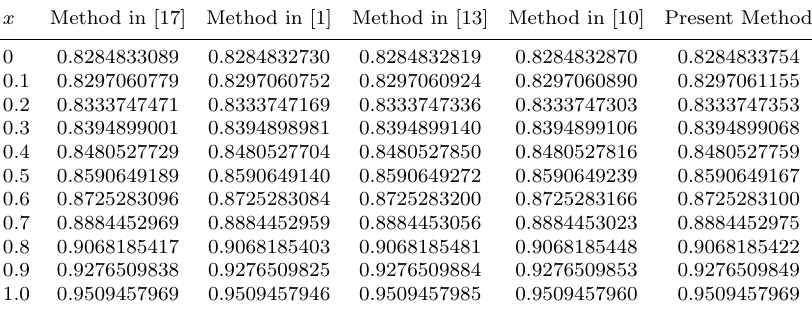
Table 4. Numerical results for Example